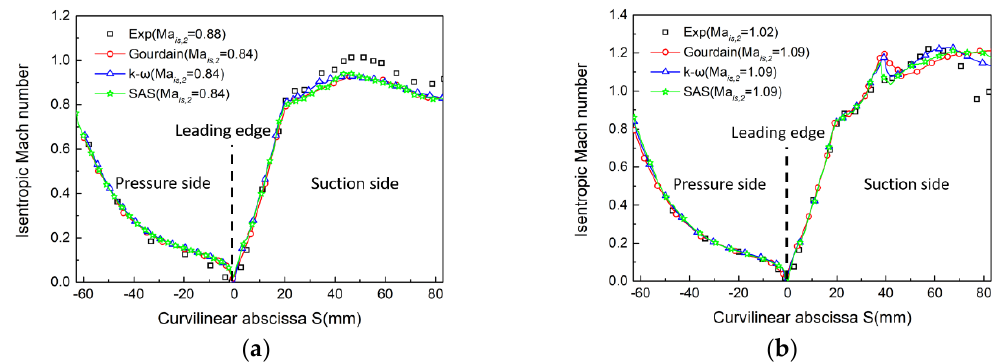
Figure 5. Isentropic Mach number distributions along the vane: ( a ) MUR129; ( b ) MUR241.